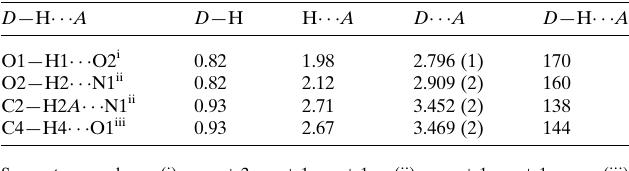
Table 1 Hydrogen-bond geometry (A˚ , (cid:2) ).